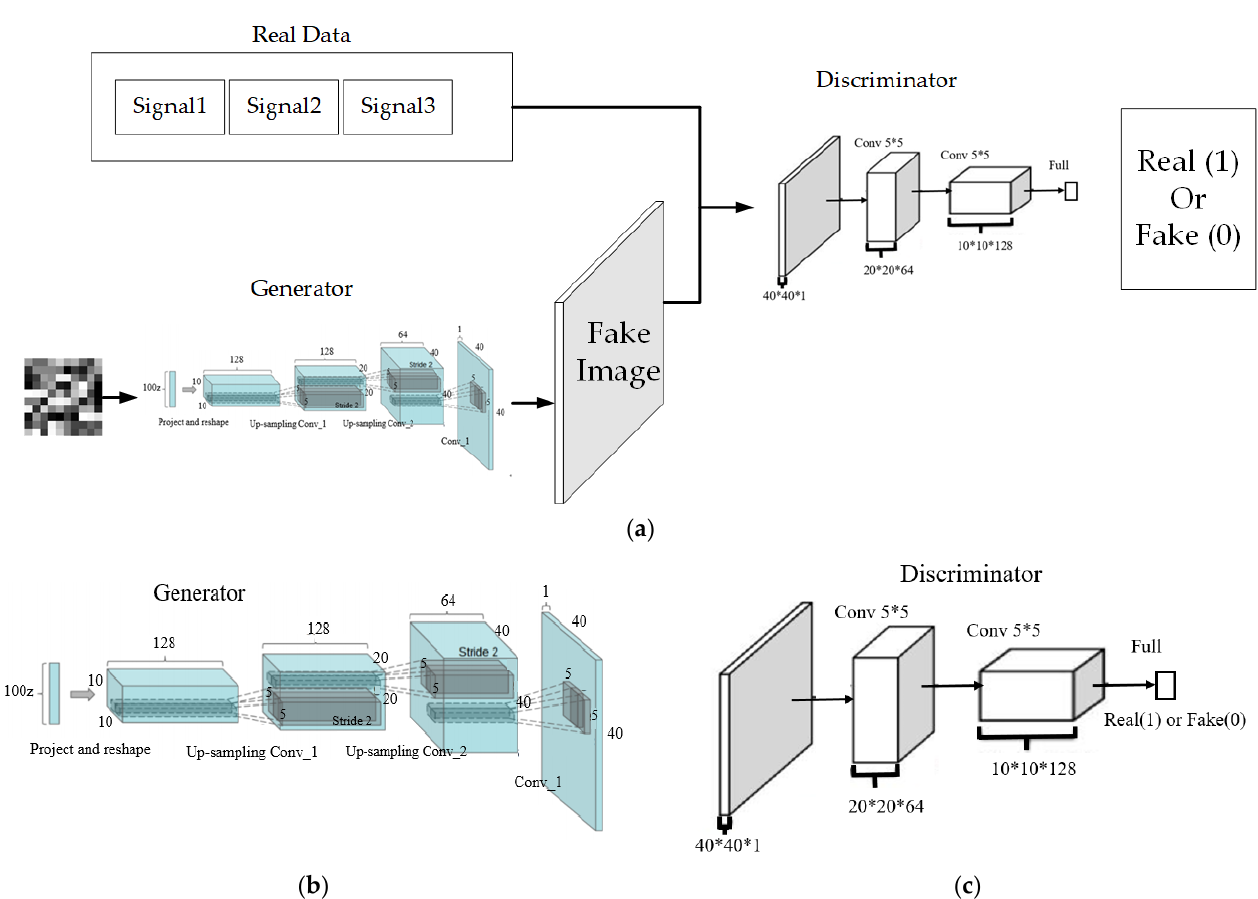
Figure 5. DCGAN: ( a ) DCGAN architecture diagram; ( b ) Generator architecture diagram; ( c ) Discriminator architecture diagram.